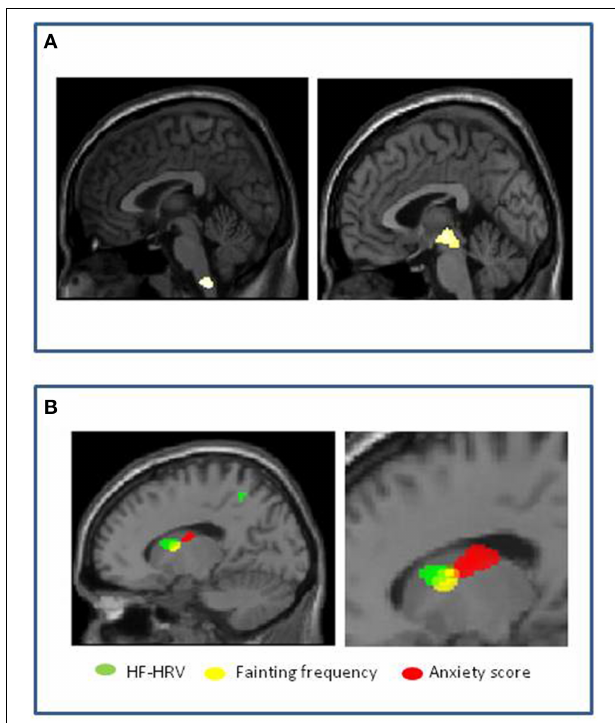
FIGURE 4 | Vasovagal syncope: Associations with brain structure (Beacher et al., 2009). (A) Significant group differences in medulla and midbrain volumes between healthy people with and without history of fainting, with reduced volume associated with vasovagal syncope. (B) Correlation of volume within left caudate nucleus in people with history of fainting. Reduced gray matter volume in contiguous regions correlated with increased anxiety score (red), increased fainting frequency (yellow) and increased high frequency heart rate variability (HF-heart rateV)